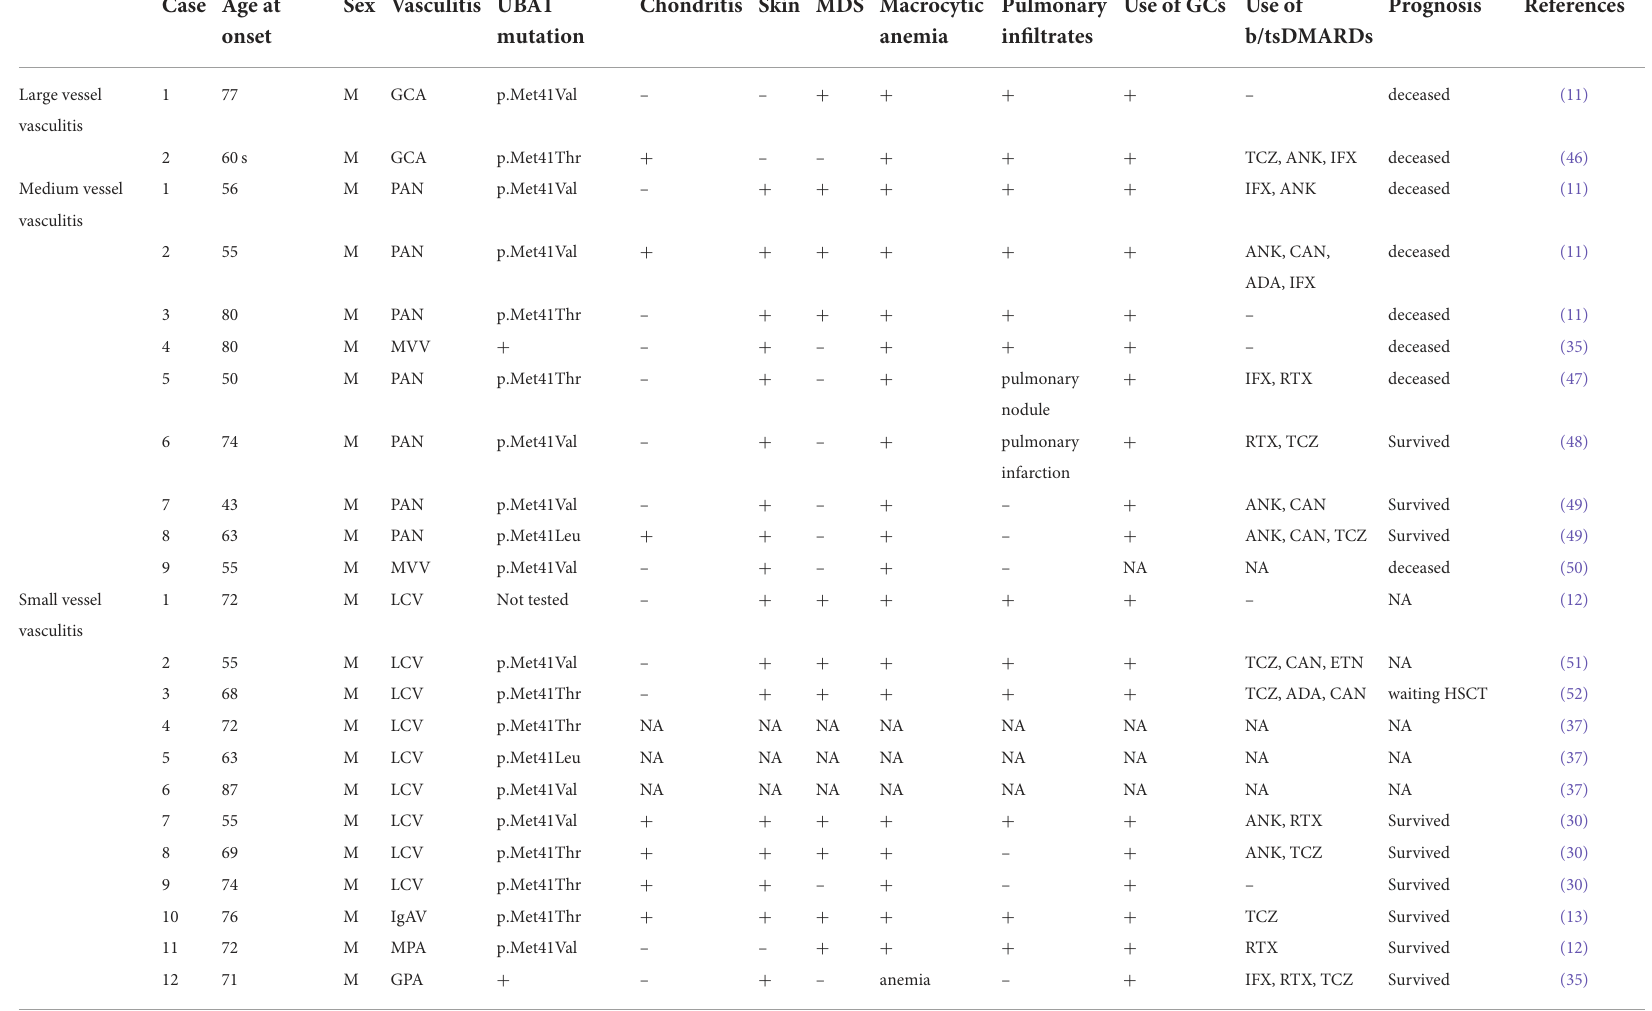
TABLE 1 Vasculitis associated with VEXAS syndrome identified by our literature